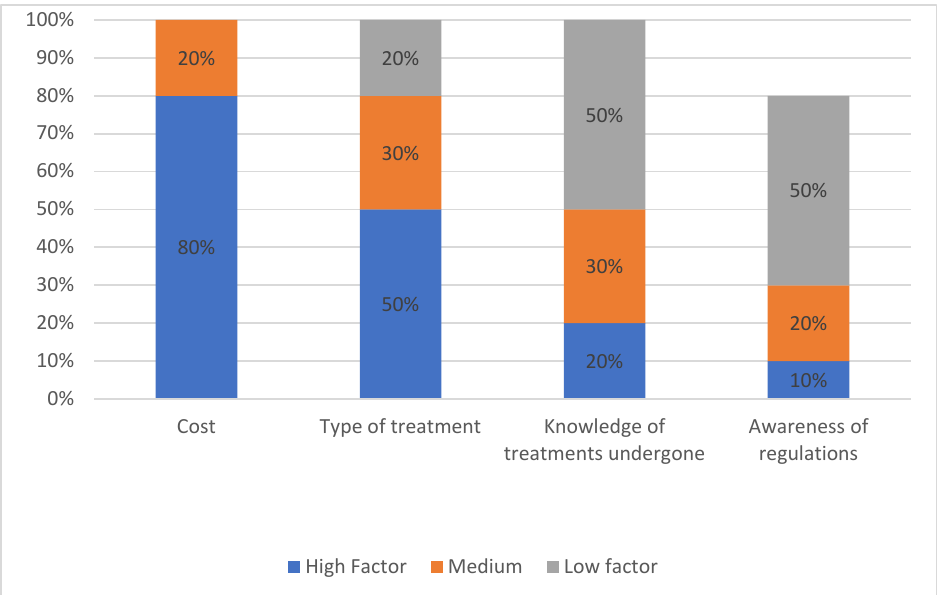
Figure 6. Criteria for Clinic selection in order of importance .